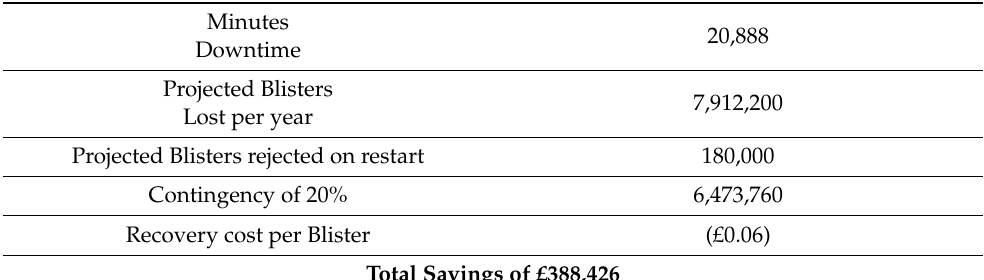
Table 3. Benefits.